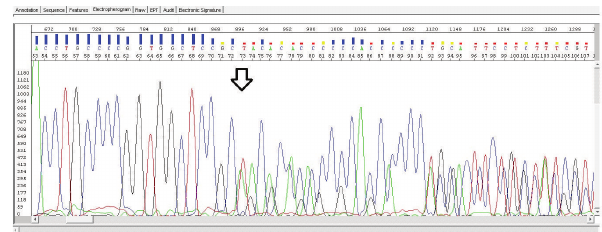
Figure 5: Maternal heterozygous del TACACCC site.